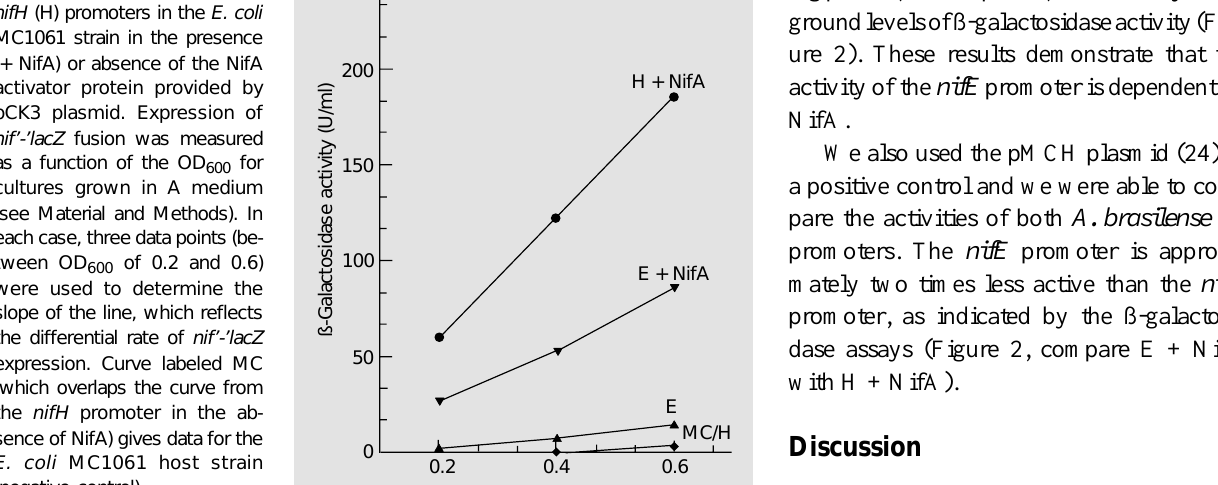
Figure 2. In vivo expression of nif’-’lacZ from the nifE (E) and nifH (H) promoters in the E. coli MC1061 strain in the presence (+ NifA) or absence of the NifA activator protein provided by pCK3 plasmid. Expression of nif’-’lacZ fusion was measured as a function of the OD 600 for cultures grown in A medium (see Material and Methods). In each case, three data points (be- tween OD 600 of 0.2 and 0.6) were used to determine the slope of the line, which reflects the differential rate of nif’-’lacZ expression. Curve labeled MC (which overlaps the curve from the nifH promoter in the ab- sence of NifA) gives data for the E. coli MC1061 host strain (negative control).